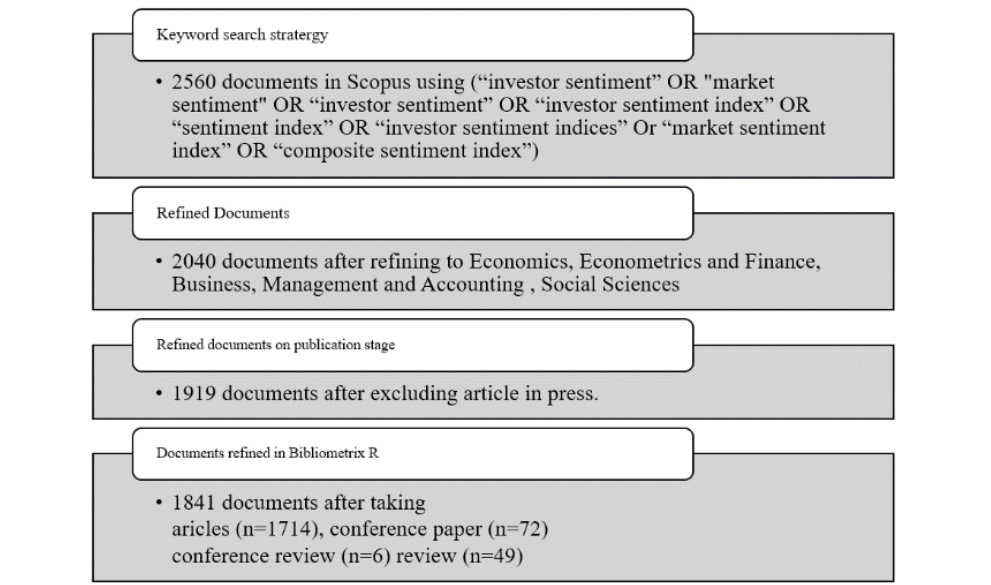
Figure 2. Inclusion-exclusion